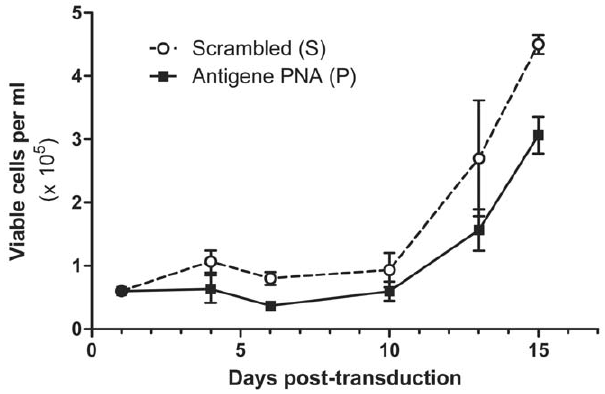
Figure 4. KB-8-5 cells were transduced with IVP-scrambled (S) or IVP-antigene PNA (P) and media containing the chemother- apeutic paclitaxel (400 ng/ml) was added one day post- transduction. Cells were trypsinized every 2–3 days, resuspended in a set volume of media, and counted with Trypan blue. The concentration of viable cells is plotted as a function of time. Error bars represent the standard error of the mean of three replicate counts.